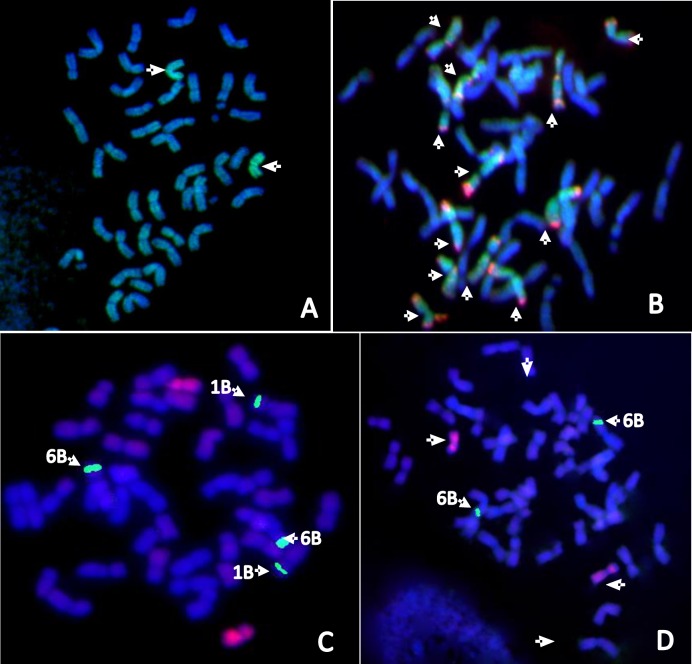
GISH/FISH images of mitotic chromosomes.A- DSL1Mg(1D), B- DSL1Mg(1D), C- DSL1Mg(1A) and D- DSL1Mg(1B). GISH revealed two Ae. geniculata chromosomes and 12 instead of 14 D-genome chromosomes in DSL1Mg(1D). The DSL1Mg(1A) was identified from total 42 chromosomes, two Ae. geniculata chromosomes and four 45srDNA signals. The DSL1Mg(1B) was identified from total 42 chromosomes, two Ae. geniculata chromosomes and two 45SrDNA signals.